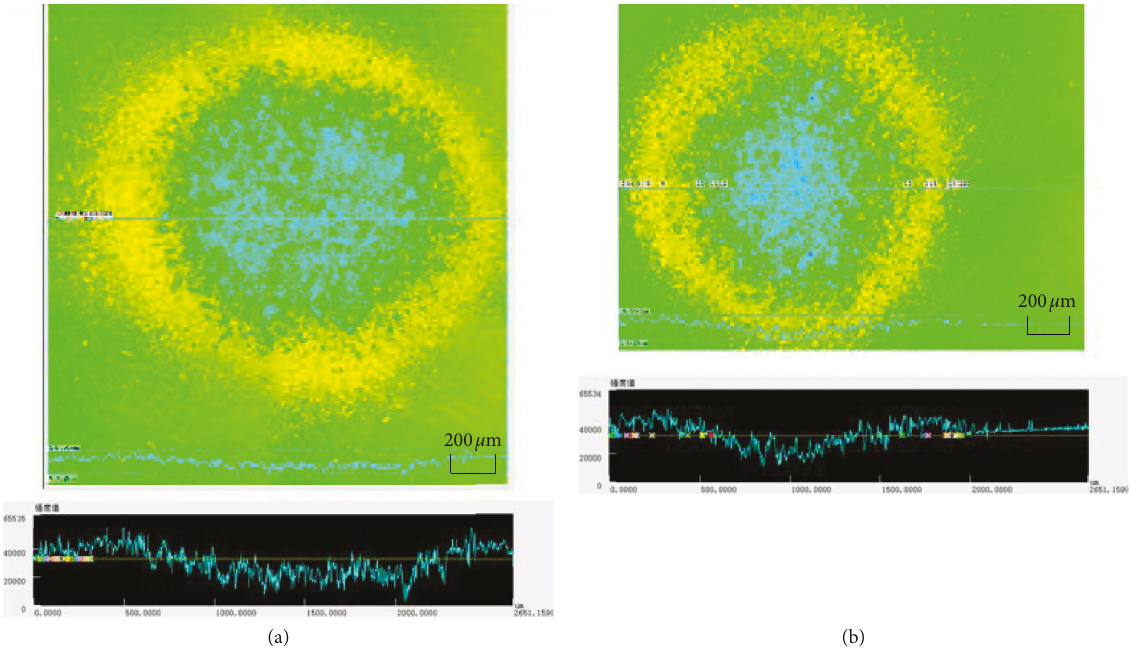
Figure 11: The erosion surface morphology of quartz glass. (a) Without vibration. (b) With vibration.